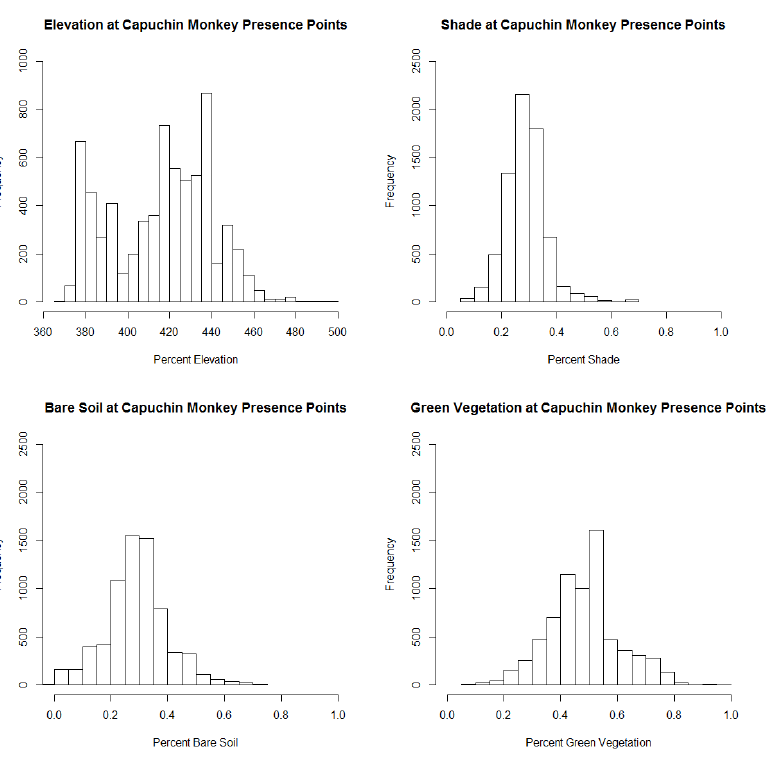
Figure 2. Elevation, percent bare soil, shade, and green vegetation histograms of bearded capuchin monkey presence points. Percents are presented as fractional